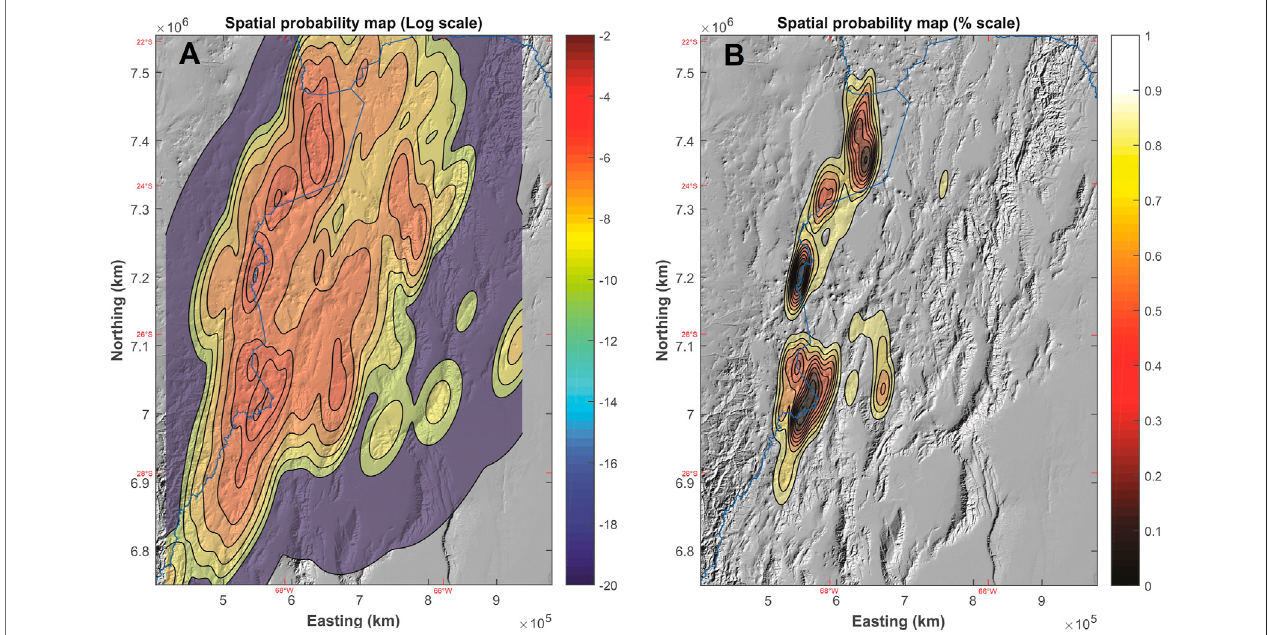
FIGURE 3 | Spatial probability maps of volcanic activity for our study area: (A) Raw probabilities. Probability density functions were obtained after applying the kerneldensity estimationmethodand areshown asprobabilityisocontoursonalogarithmicscaletoillustrateorder-of-magnitudechanges. (B) Cumulative probabilities. Givenavolcanicevent,thereisa50%chanceitwilloccurwithintheareade fi nedbythe0.5isocontour.Thelocationsofthe fi veclustersde fi nedinthisworkareindicated. Main coordinate grid is in UTM units (zone 19 S) as MatHaz works in a plane coordinate grid system. Legend units are events/km 2 . The political border between Chile,ArgentinaandBoliviaisdepictedforreference(blueline).ASTERDigitalelevationmodelusedasabackgroundimagefollowsagreyscalecolourscheme:thewhiter the pixel, the higher the